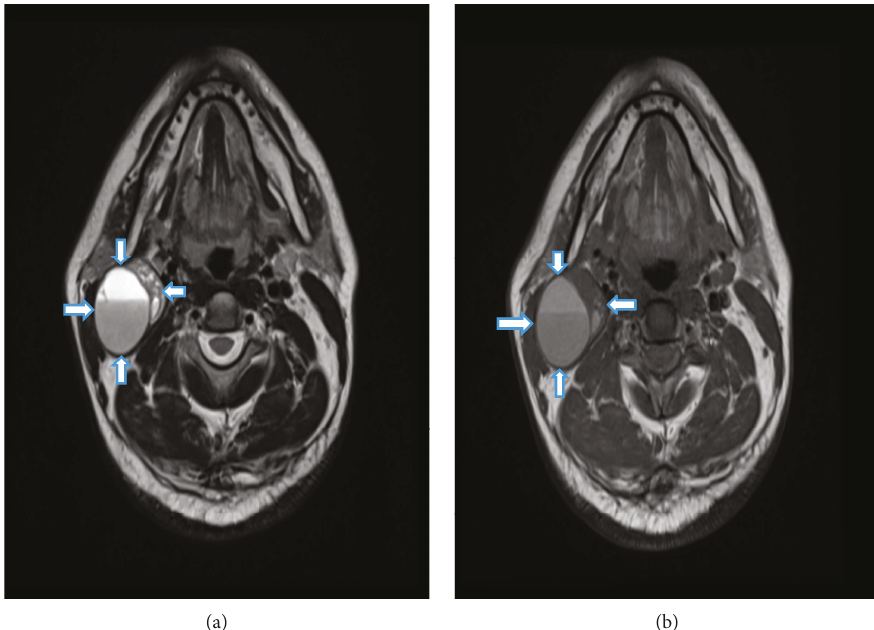
Figure 3: (a) T2-weighted magnetic resonance imaging shows hyperintense fl uid- fl uid level and isointense eccentric solid area (arrows showing edge of the tumor). (b) T1-weighted magnetic resonance imaging shows hyperintense fl uid- fl uid level (arrows showing edge of the tumor).